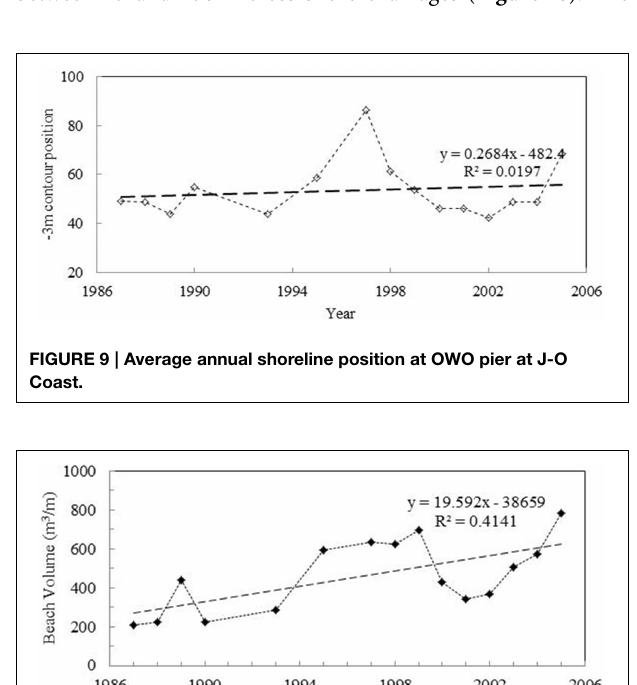
FIGURE 8 | Variability of beach profile shape at J-O Coast (A) Concave, erosion profile (B) profile with steep shoreface and sub tidal berm (C) composite, dissipative profile with steep shoreface and gentle lower beach. Corresponding year of all profiles is given in “avxy” where “xy” is the measurement year.